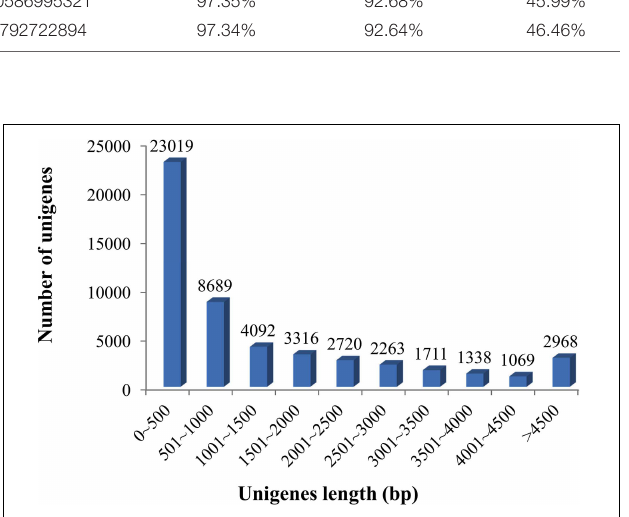
FIGURE 1 | Length distributions of the assembled unigenes in elongate loach. Of all unigenes (51,185), 44.97% (23,019) were shorter than 500 bp, 16.98% (8,689) ranged from 501 to 1,000 bp, 14.47% (7,408) from 1,001 to 2,000 bp, and 23.58% (12,069) longer than 2,000 bp.